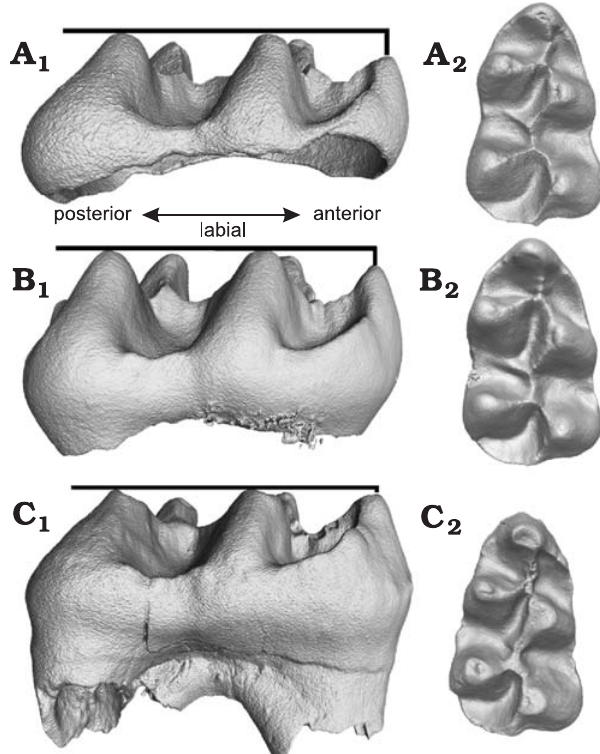
Fig. 3. Micro-CT images, showing the relative height of the five main cusps. In Megacricetodon hellenicus sp. nov. ( A , IAUU AL-N-2096; B , IAUU AL-N-2097) from Aliveri South quarry, Greece (MN4, Early Miocene) the anteroconid is lower than the rest of the cusps. In Megacricetodon primitivus (Freudenthal, 1963) ( C , VLT-167) from Valtorres, Spain (MN5, Middle Miocene) the anteroconid is of similar height than the other